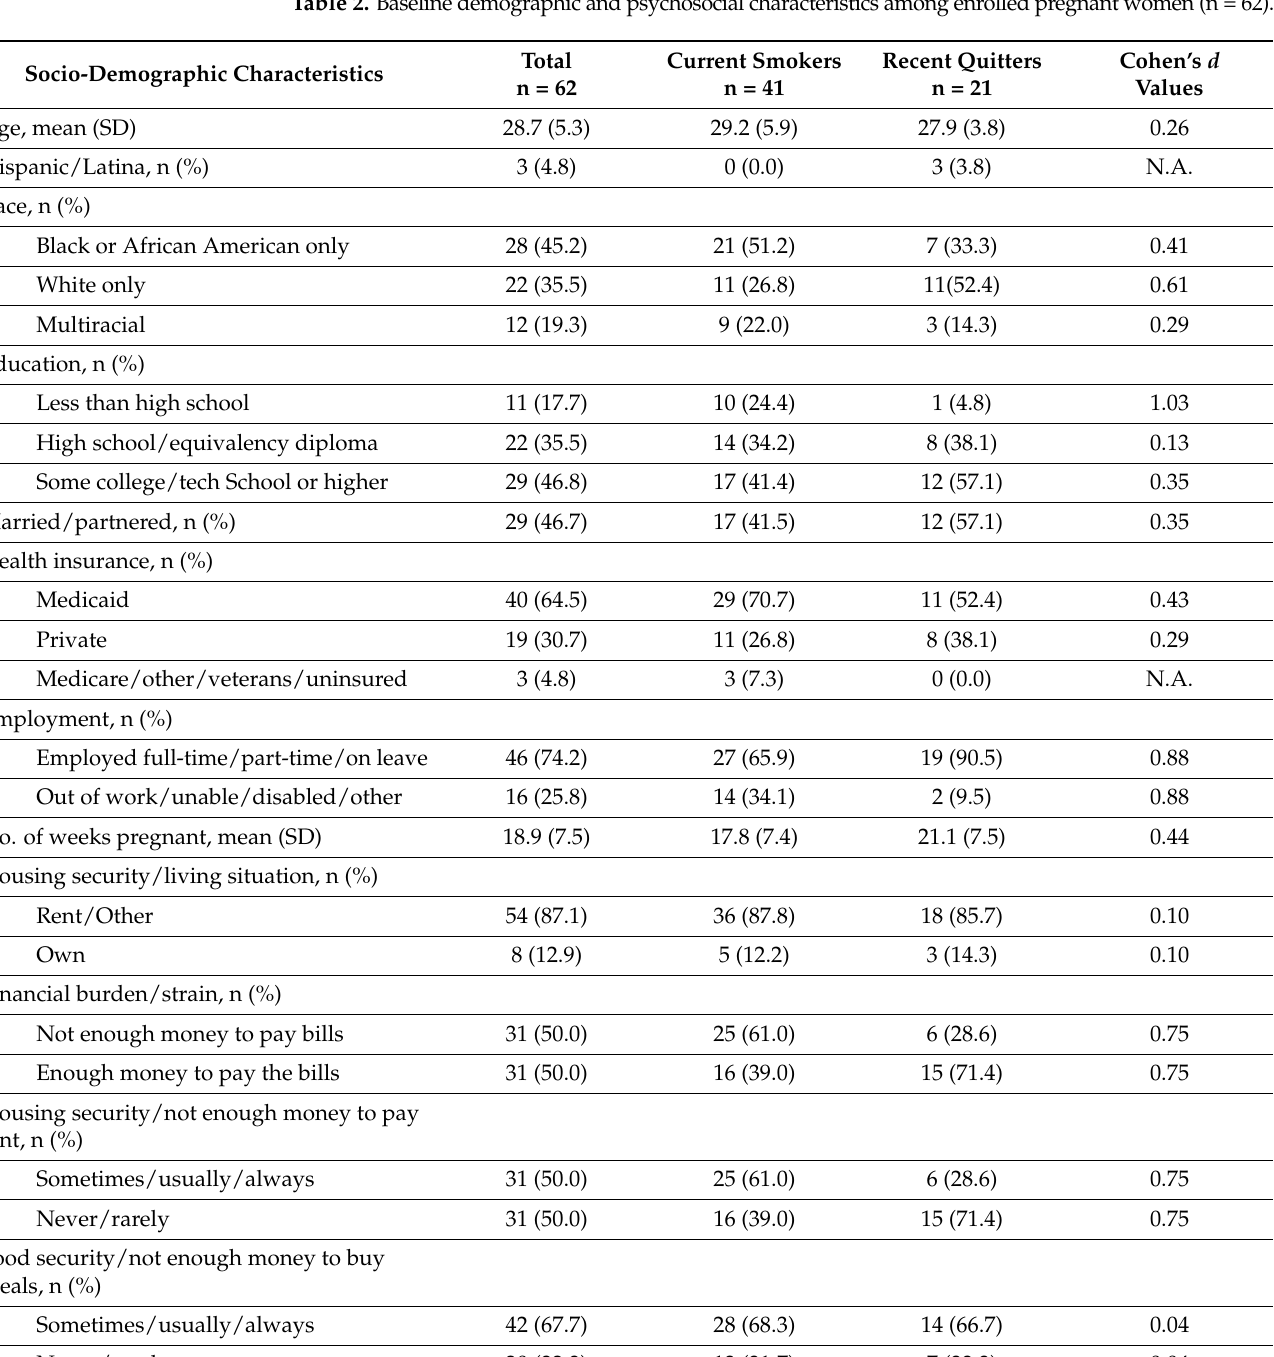
Table 2. Baseline demographic and psychosocial characteristics among enrolled pregnant women (n =